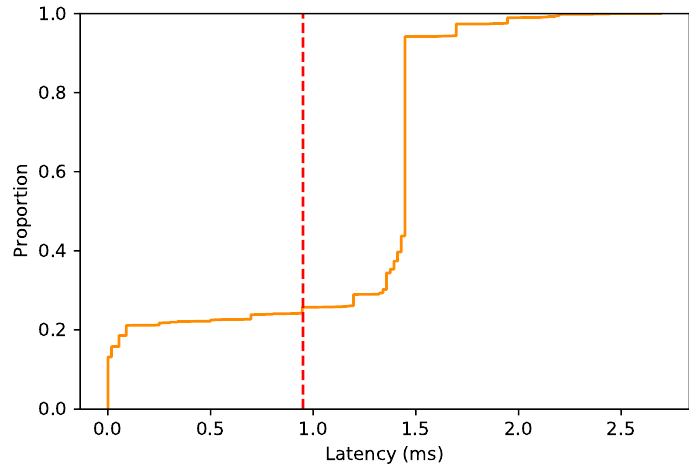
Figure 7. ECDF of the latency gain when the predictor activates PD.